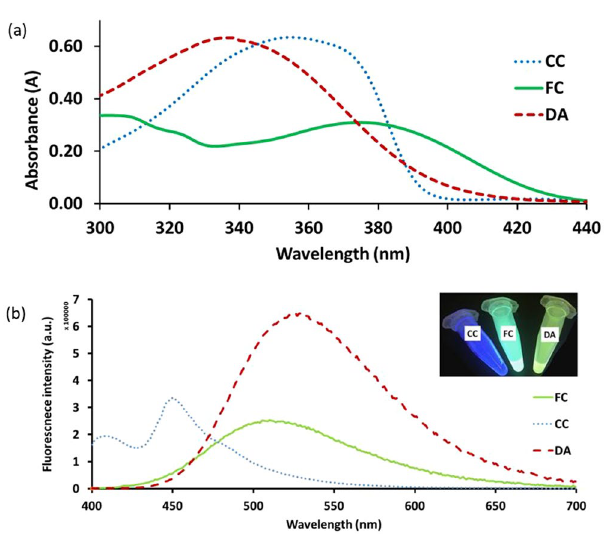
Figure 2. ( a ) Absorption spectra for each of the compounds (CC = 2.2 × 10 − 5 M, FC = 1.6 × 10 − 5 M and DA = 1.6 × 10 − 5 M) in ethanol. ( b ) Fluorescence spectra for each of the compounds (CC = 2.2 × 10 − 3 M, FC = 1.6 × 10 − 3 M and DA = 1.6 × 10 − 3 M) in ethanol. Inset: Photograph taken under UV light (390 nm) for each of the compounds (CC, FC and DA) in